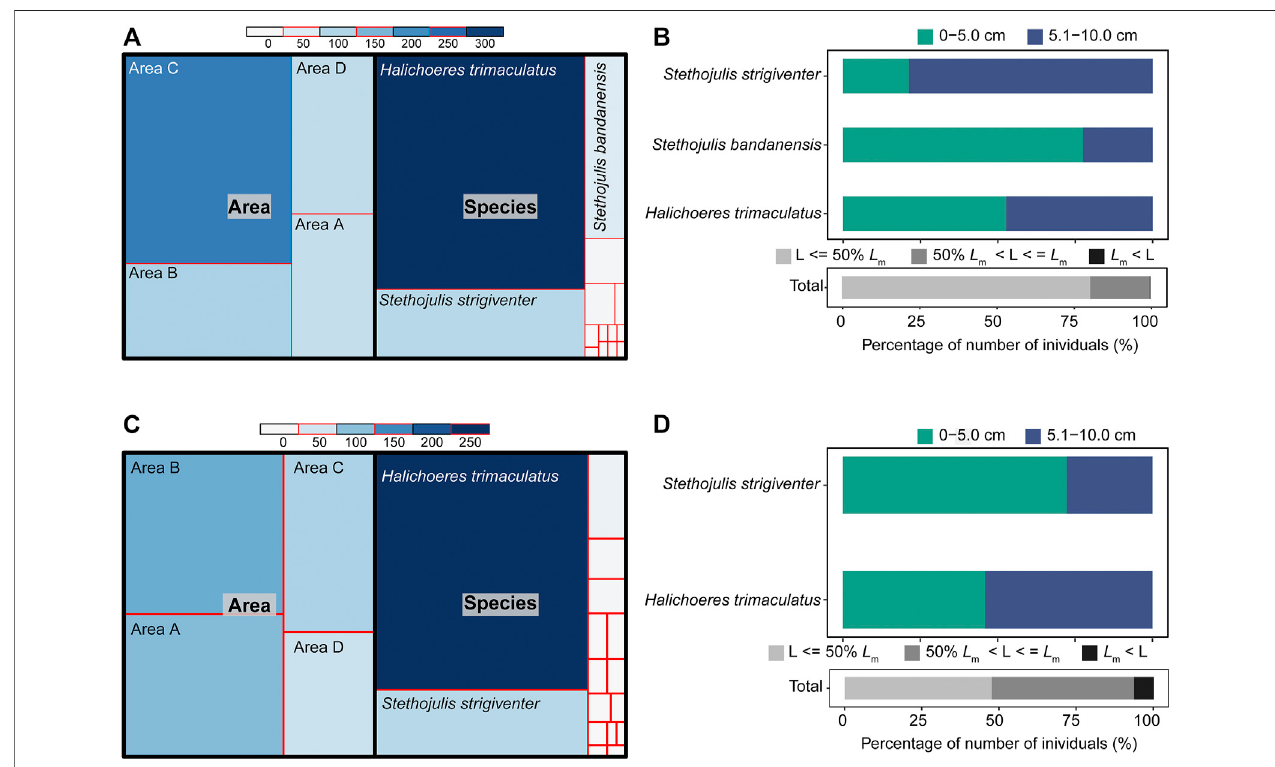
FIGURE3|(A) Thenumberofindividualsbyareaandbyspeciesand (B) theproportionofindividualswithsizes(totallengthTL,cm)comparedtothesizeat50%of sexual maturity ( TL m) using the BS method. (C) The number of individuals by area and by species (D) and the proportion of individuals with sizes (TL, cm) compared to the size at 50% of sexual maturity ( TL m) using the UVC